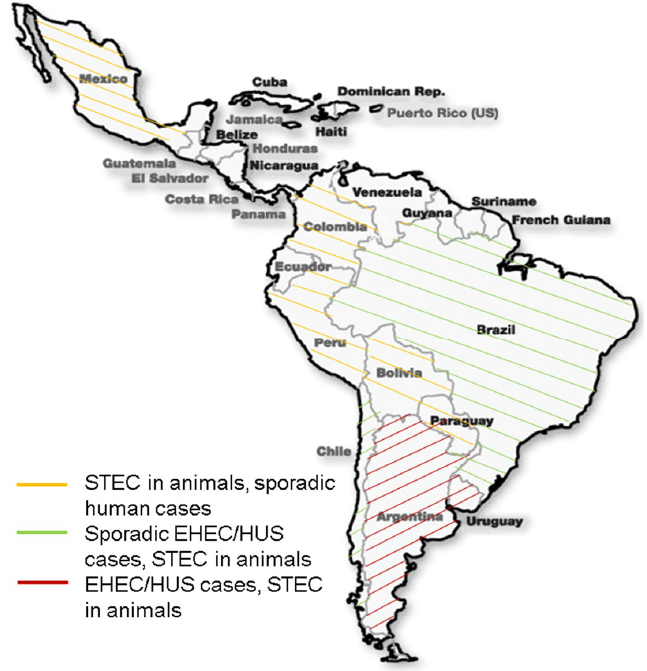
Figure 1. Geographic distribution of STEC/EHEC isolates and cases in Latin America. The map present the predicted distribution of STEC isolates in Latin American countries based on different epidemiological studies [6,7]. Different STEC serogroups are present in animals, mainly cattle, throughout the region, but the majority of EHEC/HUS human cases are localized at the southern part of the